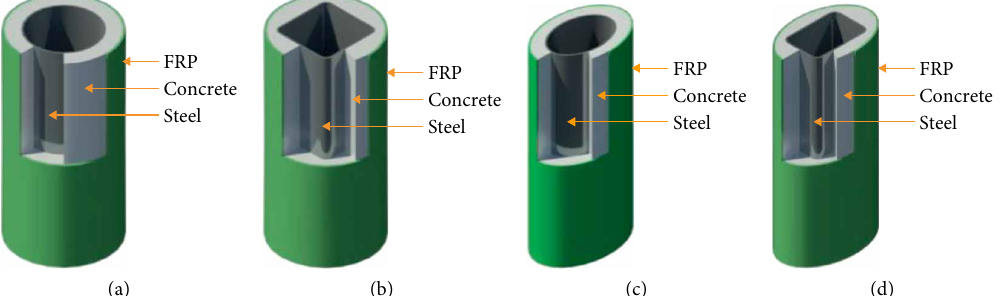
Figure 1: Hybrid DSTCs. (a) Circular DSTCs with a circular steel tube. (b) Circular DSTCs with a square steel tube. (c) Elliptical DSTCs with an elliptical steel tube. (d) Elliptical DSTCs with a rectangular steel